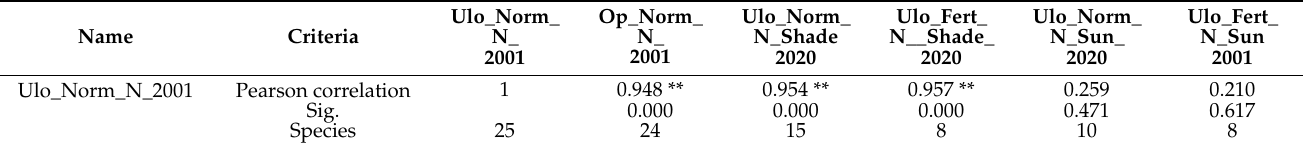
Table 4. Correlation and significance (two-tailed) of the north test plots, 10-cm media, based on the number of similar plant species, in a comparison between 2001 and 2020. High significance ** on the 5‰ level between both media Ulo and Op 2001, it remain similar until 2020 on the shade plots. The sunny parts are significant different from these.